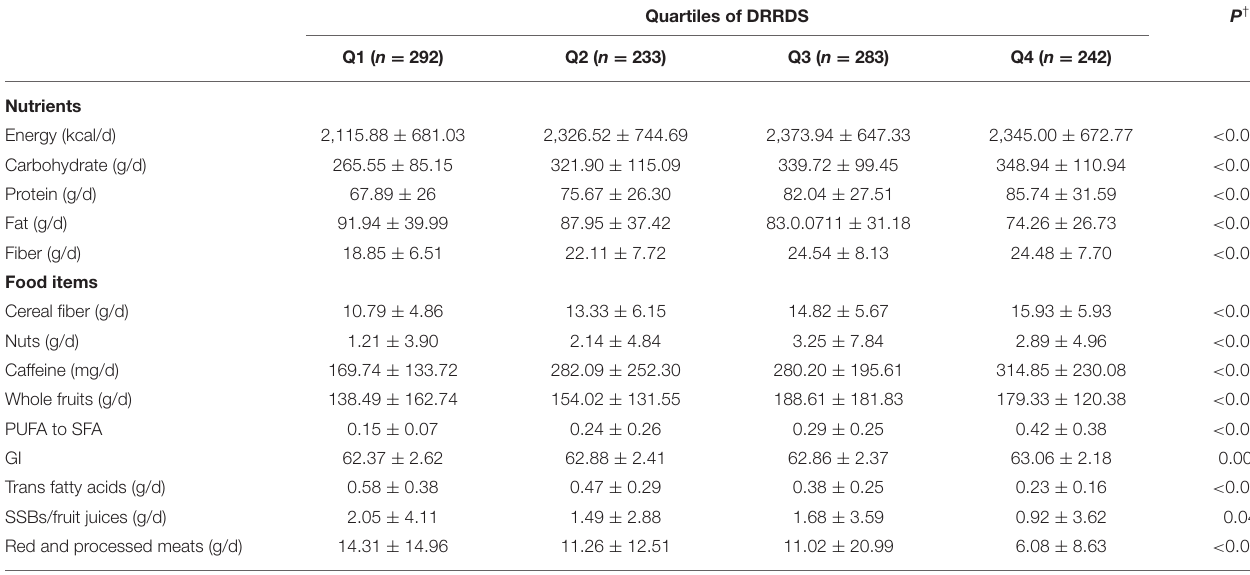
TABLE 2 | Dietary intakes of study participants across quartile categories of DRRDS * .